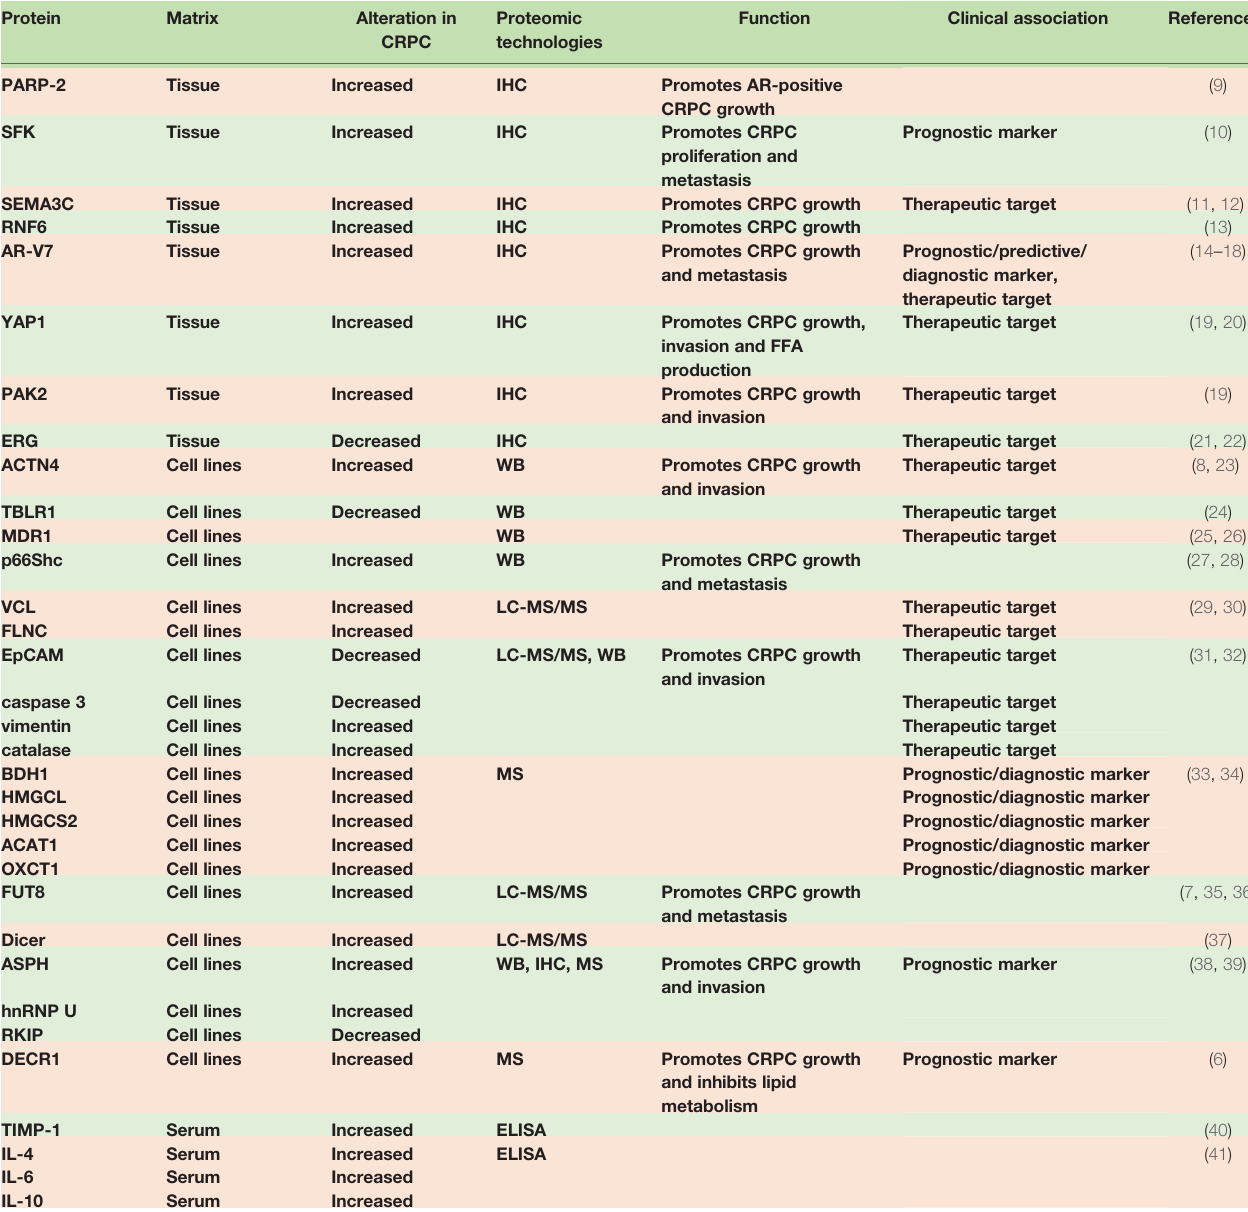
TABLE 1 | The altered proteins when CSPC progression to